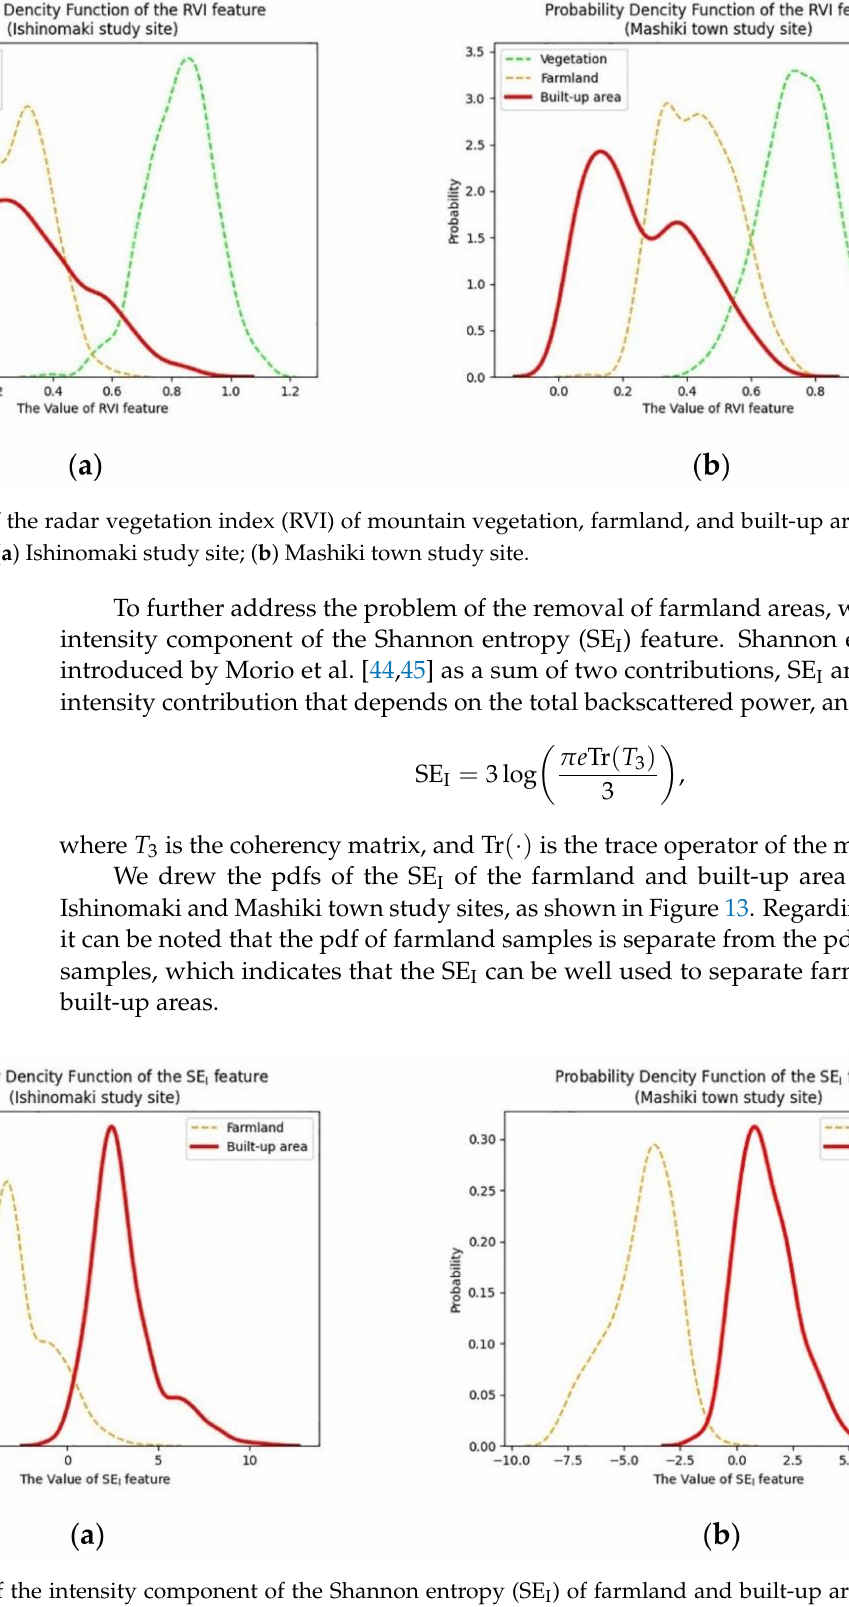
Figure 13. The pdf of the intensity component of the Shannon entropy (SE I ) of farmland and built-up area samples in different study sites: ( a ) Ishinomaki study site; ( b ) Mashiki town study